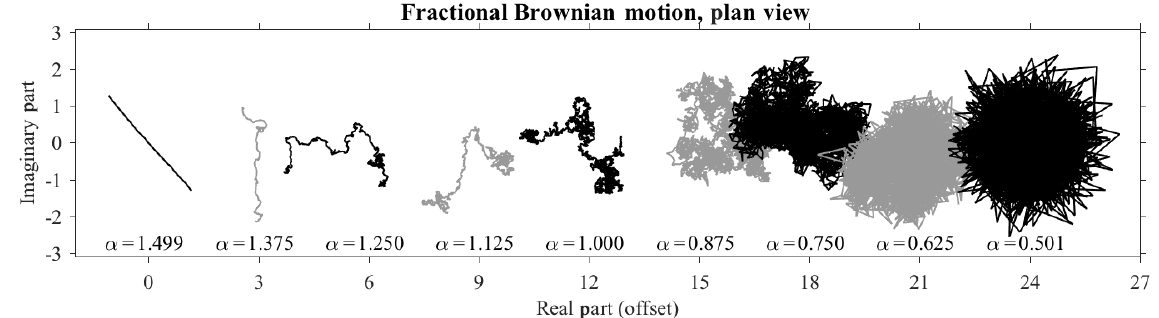
Figure 4. Plan view of realizations of complex-valued fractional Brownian motion z(t) , for nine different values of the slope parameter α , as indicated in the legend. All nine time series have been set to have unit sample variance, and the real part of each curve is offset by a value of − 3 from that for the next lower value of α . The smallest value of α , corresponding to the least smooth process, is at the right. The data aspect ratio is equal between the real and imaginary